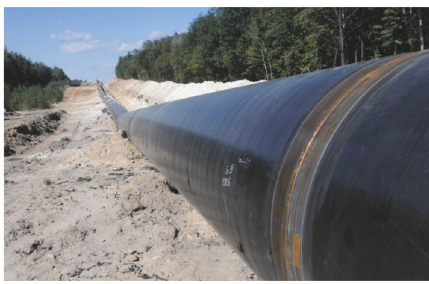
Figure 1: Investigated pipeline